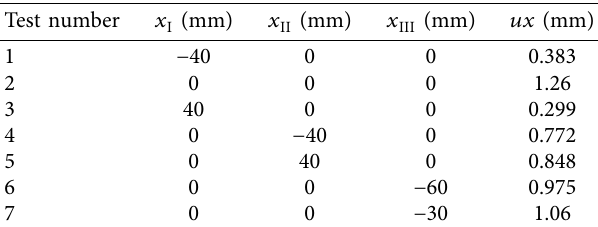
Table 10: Effect of different absolute support positions on the overall vibration displacement (the interaction between support positions were not considered).